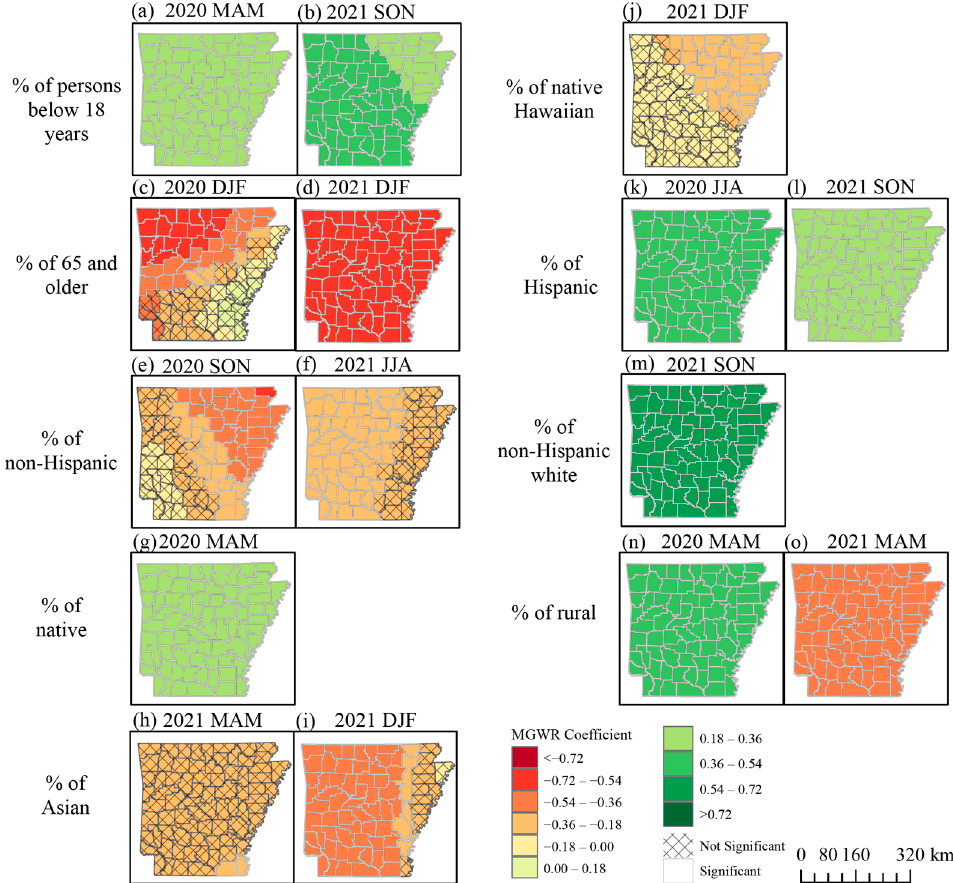
Figure 7. Spatial impacts of demographic variables on the COVID-19 rate derived from a multiscale geographically weighted regression model on COVID-19 in each county in Arkansas, US from 2020 to 2021. The unhatched regions indicate a 5% significance level. (MAM: March–April–May; JJA: